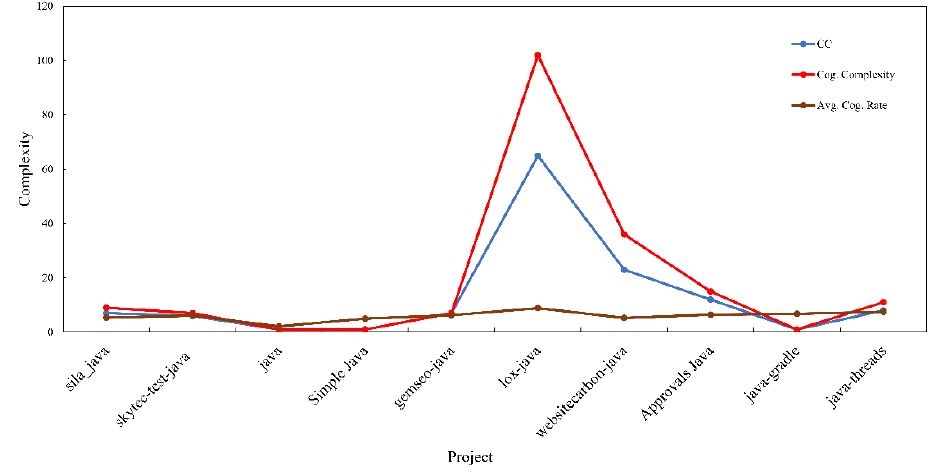
Fig. 3. Cognitive complexity rating with current complexity metrics for multiple